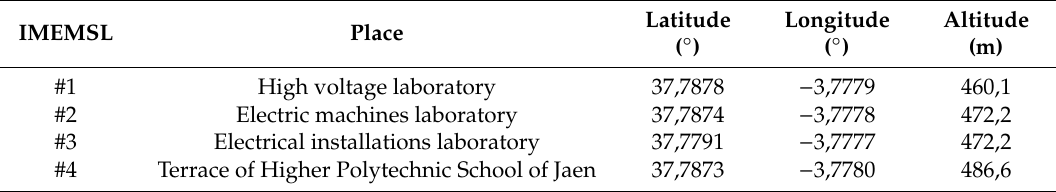
Table 6. Location of IMEMSLs.